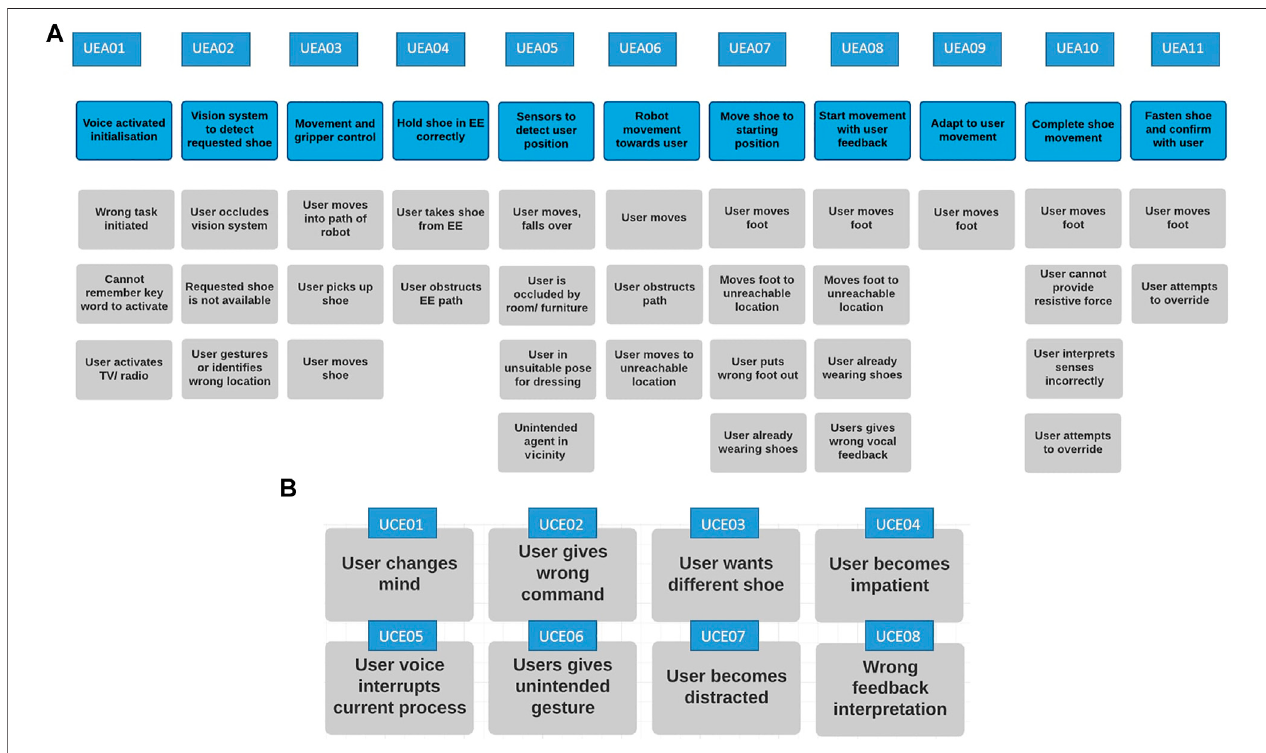
FIGURE 3 | (A) User error analysis in a dressing scenario. (B) User errors common to any task scenario element.